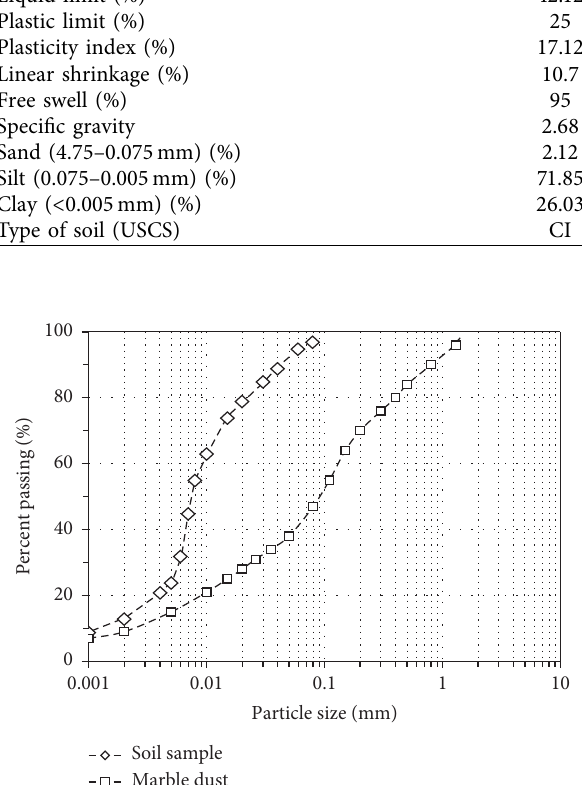
Figure 2: Grain size distribution curves for the soil sample and